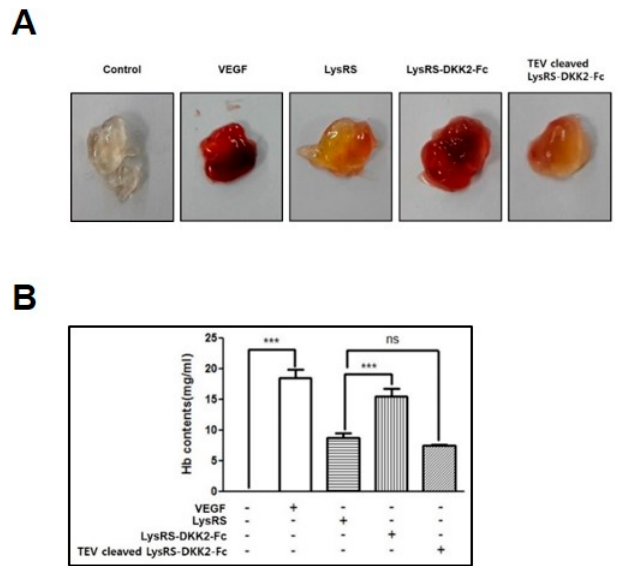
Figure 6. Recombinant DKK2-Fc induces angiogenesis in Matrigel plugs. ( A ) C57BL/6 mice were injected with 0.6 mL Matrigel containing VEGF, LysRS, LysRS-DKK2-Fc, or TEV-cleaved LysRS-DKK2-Fc. After three days, Matrigel plugs were excised from mice. ( B ) Quantification of Hb in Matrigel plugs. Error bars are the mean ± SD of three experiments in duplicate. *** p < 0.001; ns, not significant.